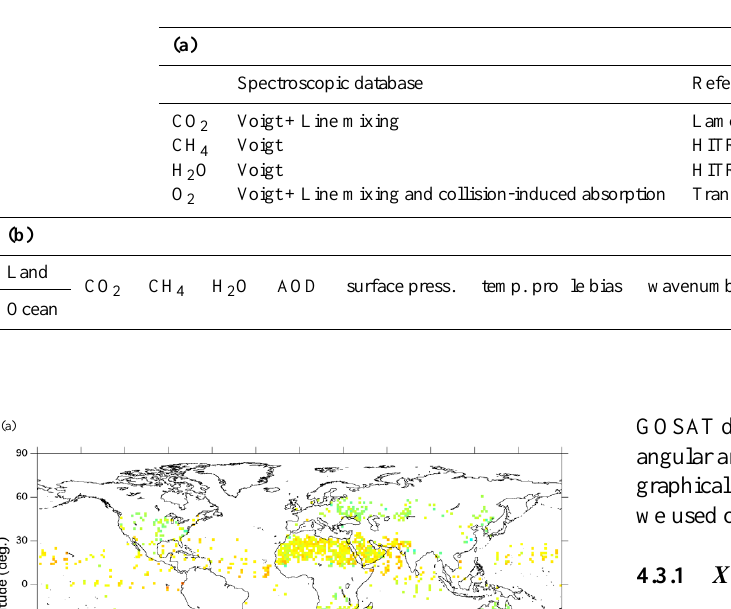
Table 2. (a) Spectroscopic databases of CO 2 , CH 4 , H 2 O and O 2 molecules and (b) parameters retrieved from bands 1 and 2 of the TANSO FTS in the Ver.01.xx.